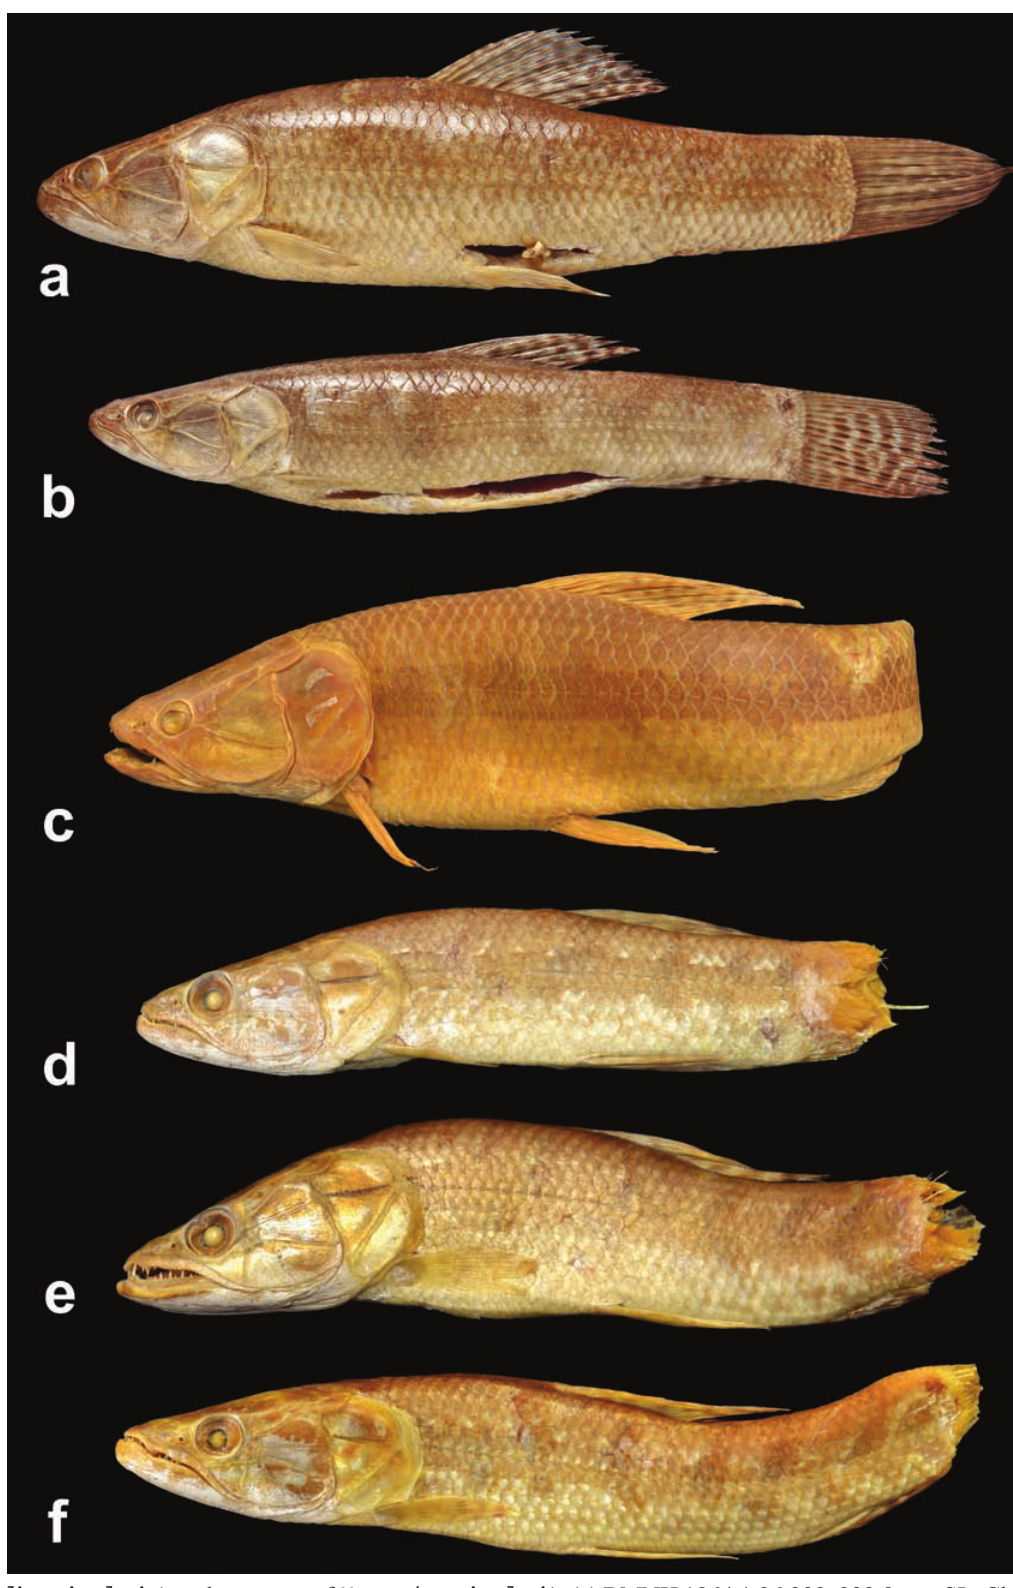
Fig. 2. Hoplias microlepis (paralectotypes of Macrodon microlepis ). (a) BMNH 1864.1.26.222, 222.8 mm SL, Chagres River, Panama; (b) BMNH 1864.1.26.309, 175.6 mm SL, Chagres River, Panama; (c) BMNH 1860.6.16.128, 276.6 mm SL, West Ecuador; (d) BMNH 1860.6.16.154-155, 96.6 mm SL, West Ecuador; (e) BMNH 1860.6.16.154-155, 108.2 mm SL, West Ecuador; (f) BMNH 1860.6.16.154-155, 118.5 mm SL, West